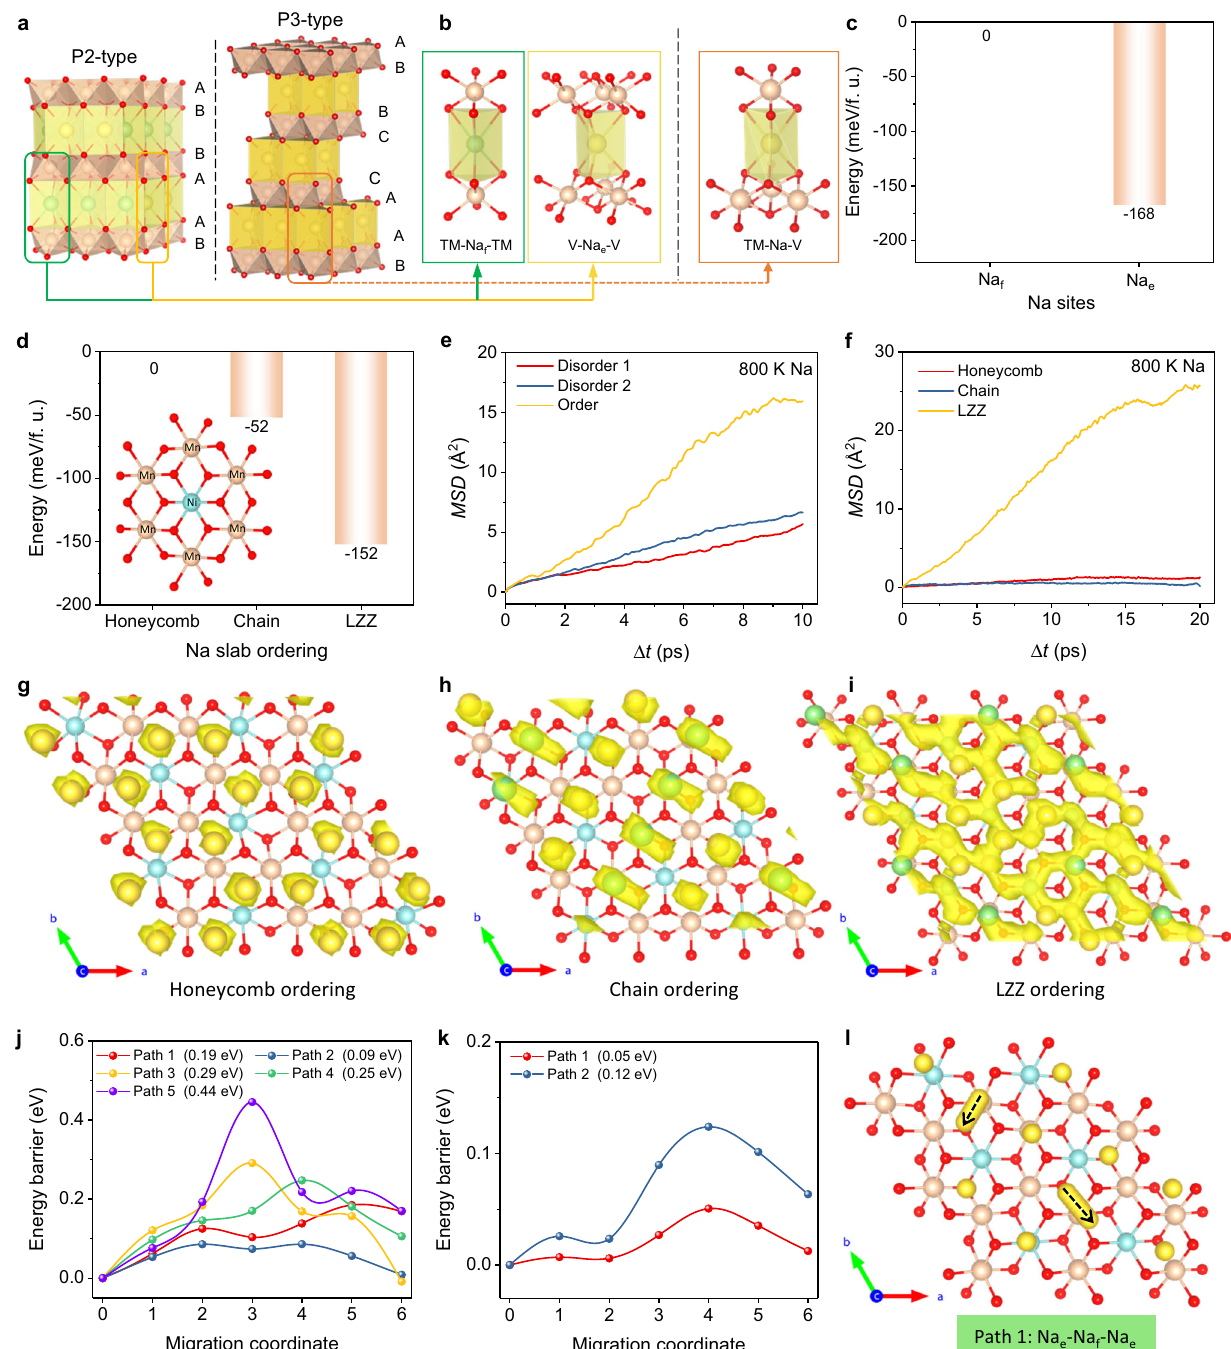
Fig. 4 | Na + kinetics in P2/P3 Na 2/3 Ni 1/3 Mn 2/3 O 2 layered oxides. a , b Crystal environmentsofNaO 6 prisminbothP2andP3phases,wherethelocalcoordination oftheNa f (2b,faces-sharing)andNa e (2d,edge-sharing)sitesinP2-phaseandtheNa (3a, face and edge-sharing) site in P3-phase are shown. c Calculated formation energies of Na e and Na f sitesinasimple P2-NaCoO 2 model. d Energy differences of thein-planeNa + orderinginP2-Na 2/3 Ni 1/3 Mn 2/3 O 2 structure,wheretheMn 4+ andNi 2+ p p ions described by a ( 3× 3)-R30° supercell in transition metal layer. e MSDs for Na-ions in P2- Na 2/3 Ni 1/3 Mn 2/3 O 2 with Na + LZZ ordering and disordering at 800K, including the Disorder1, [occ. (Na f ) = 1/6] and Disorder 2,[occ. (Na f ) = 1/12]. f